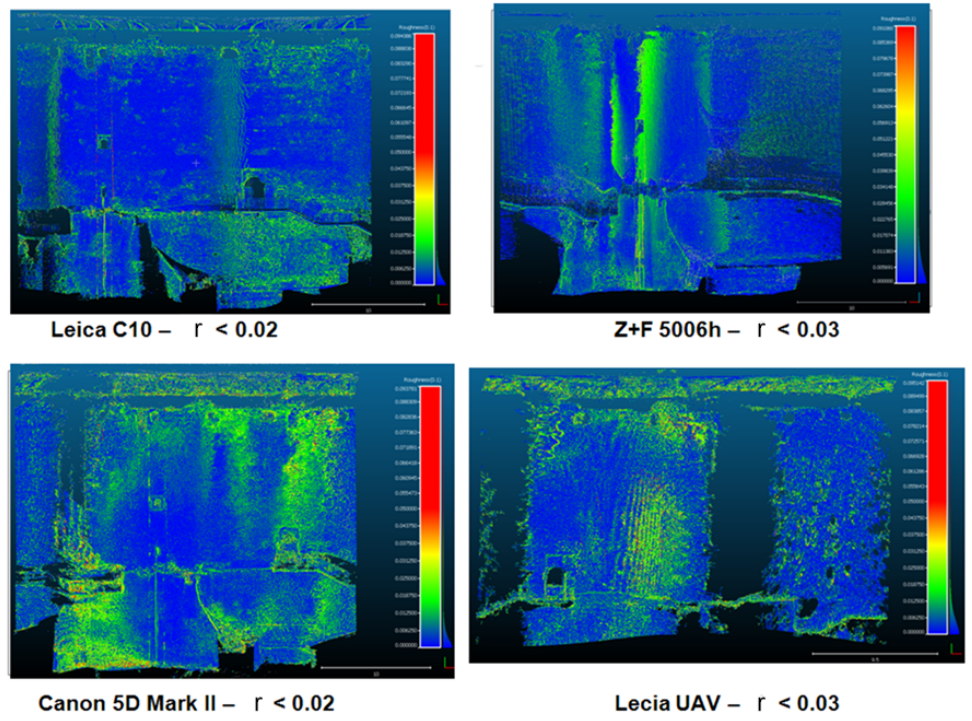
Figure 5: The quality of the point clouds of the projected tower surface acquired from different sensors (r: roughness of point clouds)